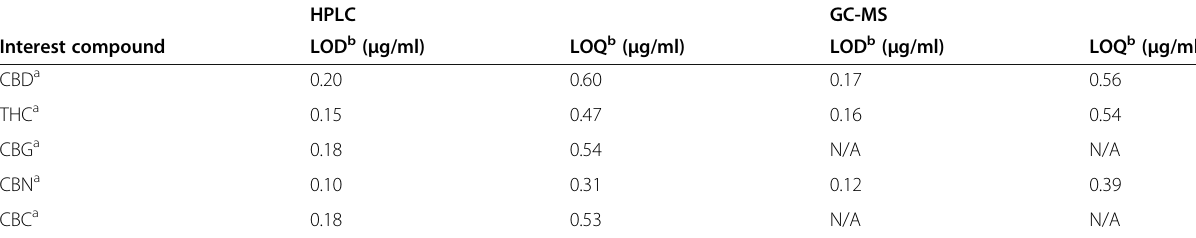
Table 4 limit of detection and limit of quantification for 5 common cannabinoids using both high performance liquid chromatography and gas chromatography for quantification. (Brighenti et al. 2017; Pellati et al.